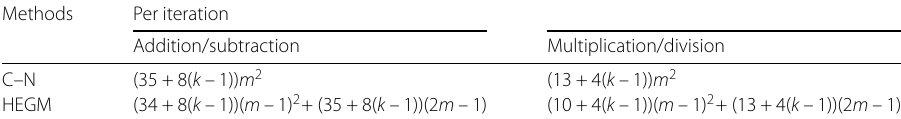
Figure 2 Exact solution for Example 1